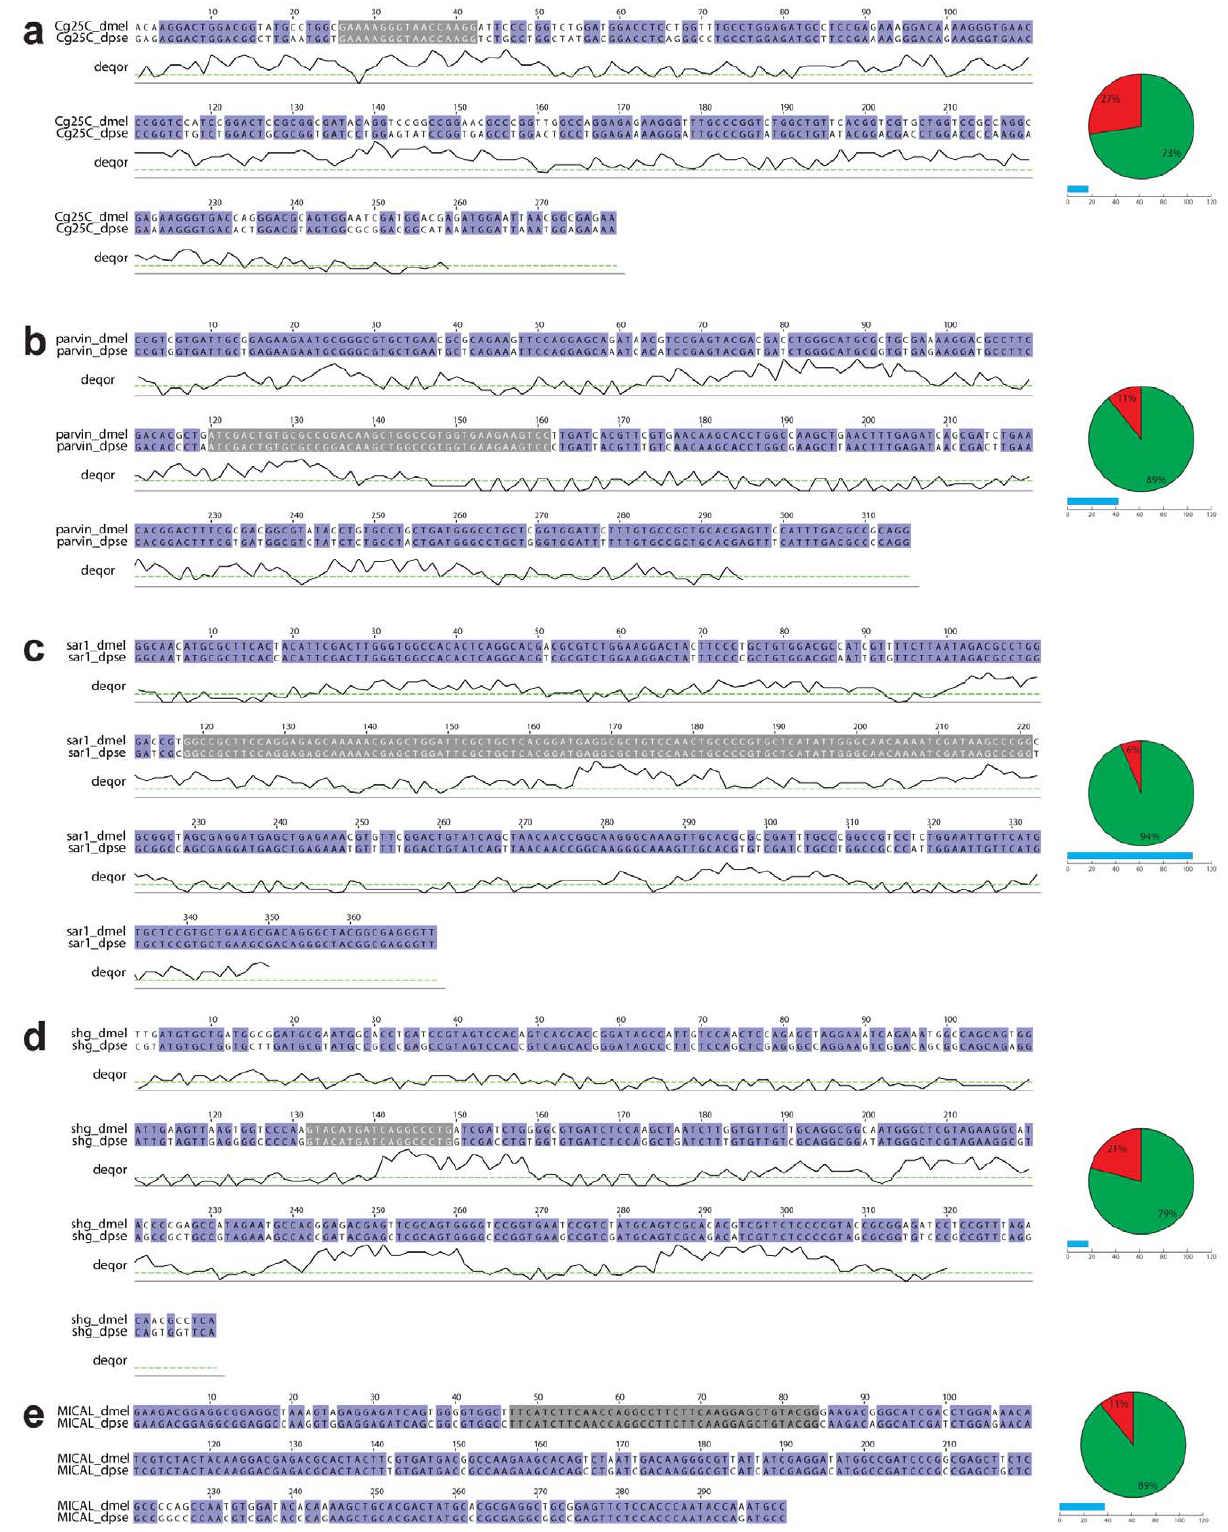
Figure 2. Pairwise sequence alignment of hairpins used in rescue experiments. Alignments between D. melanogaster and D. pseudoobscura for hairpins targeting ( a ) Cg25c ( collagen IV ), ( b ) CG32528 ( parvin ), ( c ) sar1 , ( d ) shg and ( e ) Mical . The extent of homology and the longest identical nucleotide stretch are graphically depicted next to each alignment. Matching nucleotides are shaded purple, mismatches white and the longest identical stretches are shaded grey within the alignments. The DEQOR scores are plotted below the alignments ( a–d ) and the score 5 cut-off above which the siRNA at that position is considered RNAi inefficient is depicted by a green line.